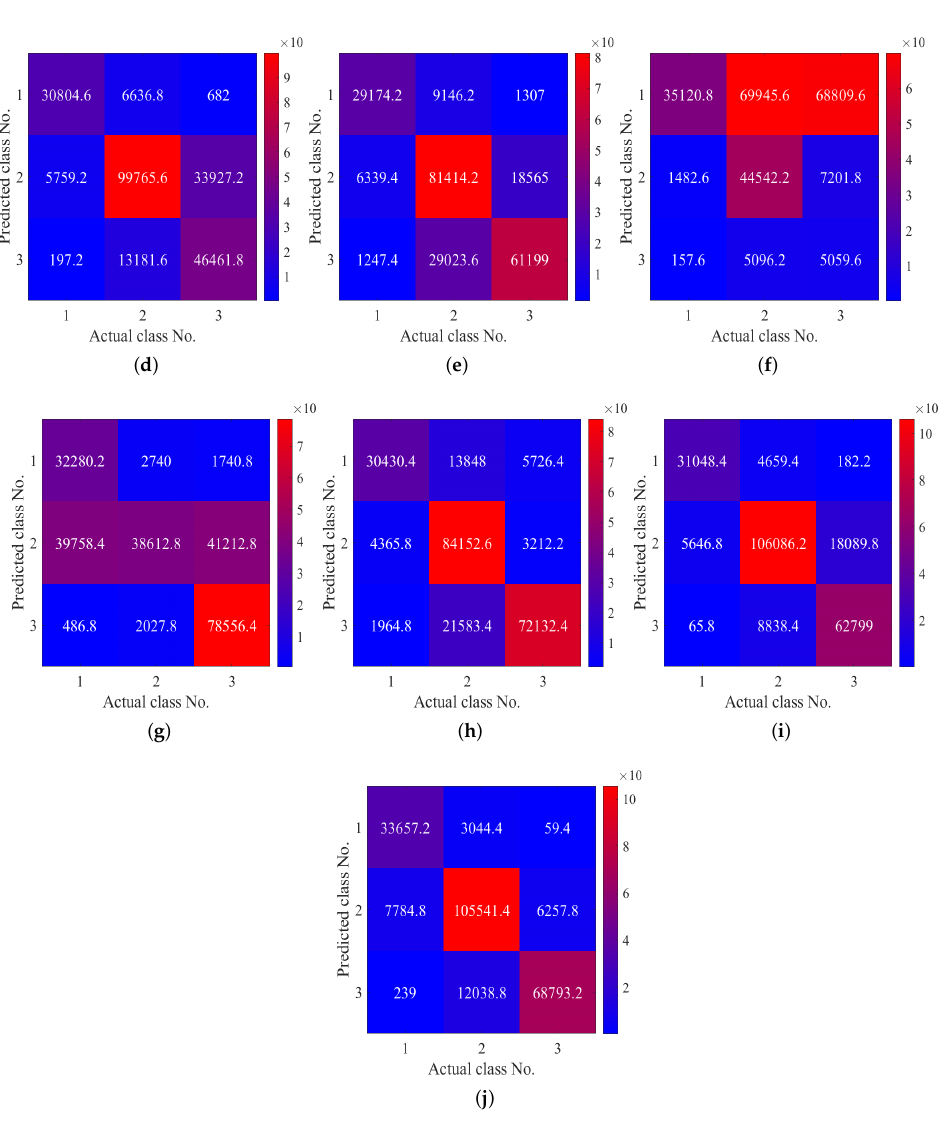
Figure A3. Confusion matrixes of classification results for Flevoland with different methods. ( a ) SVM. ( b ) Wishart. ( c ) RF. ( d ) XGBoost. ( e ) SAE. ( f ) DBN. ( g ) CV-CNN. ( h ) DSNet. ( i ) SF-CNN ( j ) Our